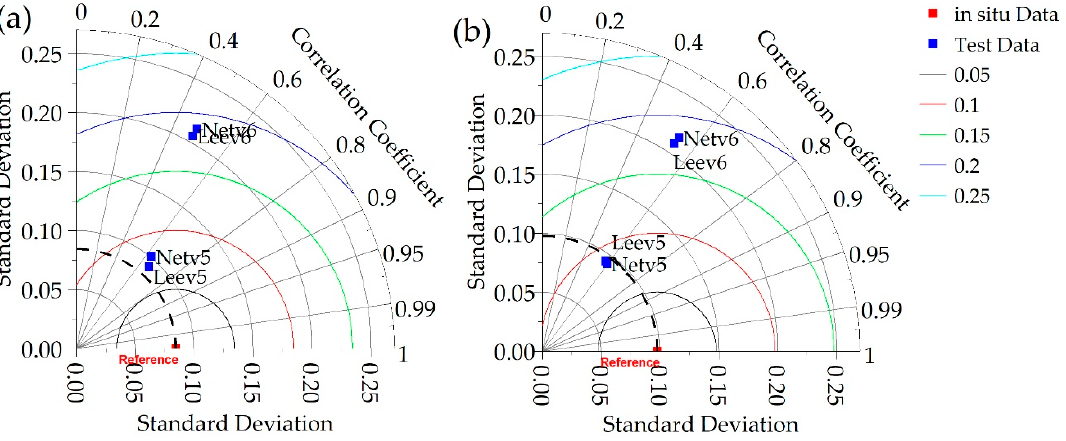
Figure 4. Comparison of the performance of the algorithms used for the two study seasons—( a ) summer and ( b ) spring—using a Taylor diagram. Where: Netv5 (QAA v5 KdPAR Nechad), Netv6 (QAA v6 KdPAR Nechad), Leev5 (QAA v5 Kd 490 nm), and Leev6 (QAA v6 KdPAR Lee).